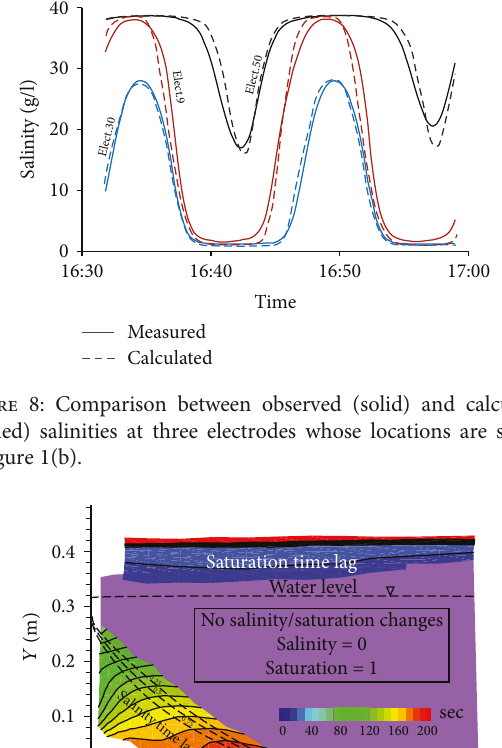
Figure 6: Vertical time lag. Upper water content sensor (WC1) lags behind the lower water content sensor (WC2), and they both lag behind the sea level fl uctuations. Salinity at the FSI (electrode 28, whose location is shown in Figure 1(b)) lags behind both water content sensors. These three sensors align vertically.